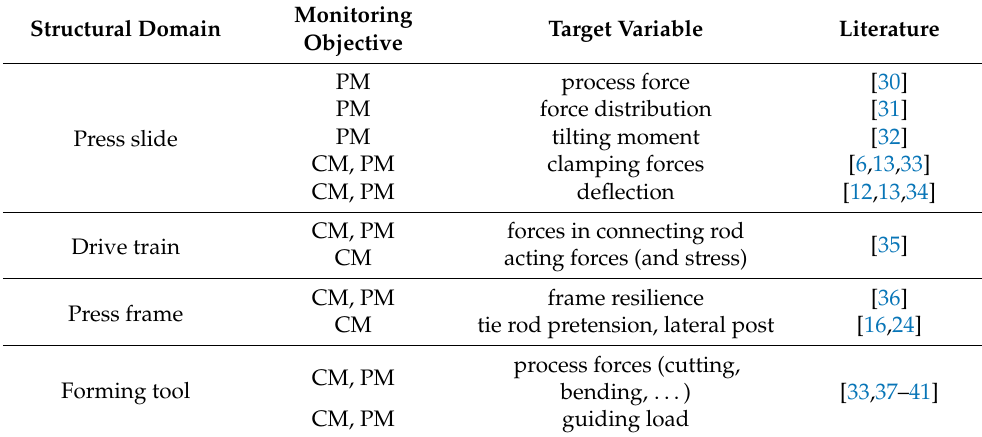
Table 1. Monitoring objectives based on the elastic machine and tool behavior (exemplary selection). Structural domain